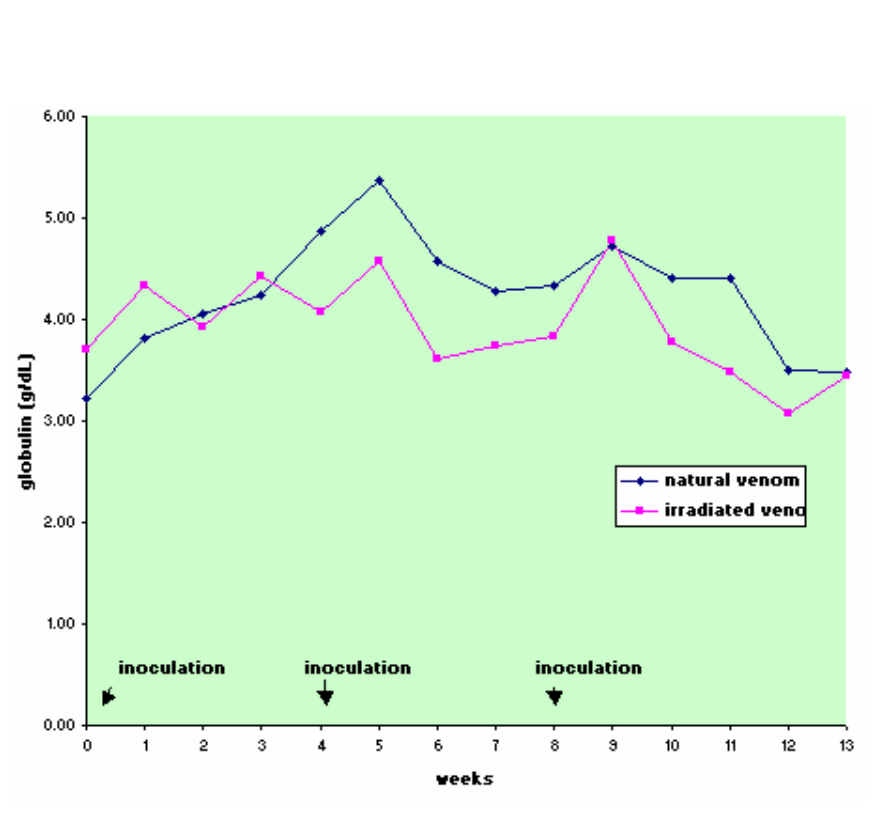
Figure 8. Mean values of globulin levels (g/dL) in sheep (n=12) inoculated with natural (NV) -irradiated (IrV) crotalic and Cobalt 60